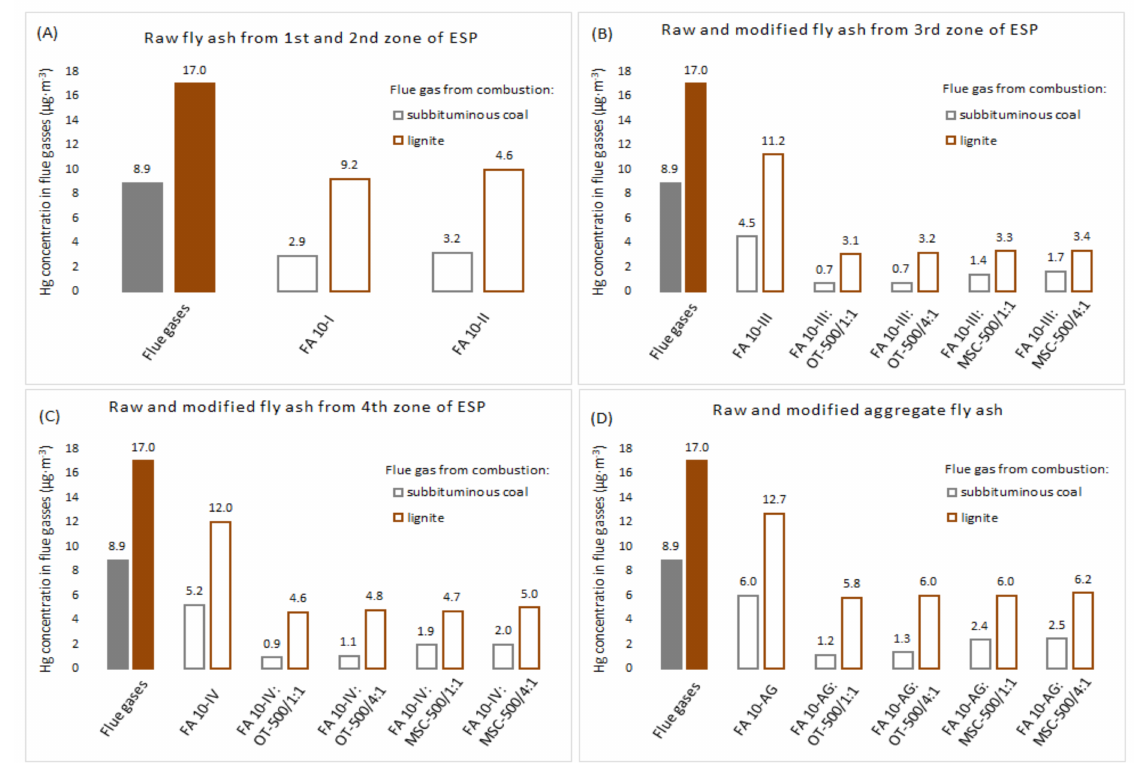
Figure 3. The concentration of mercury in raw flue gas and flue gases cleaned by RFA and MFA from ( A ) 1st and 2nd zone, ( B ) 3rd zone, ( C ) 4th zone, ( D ) aggregate